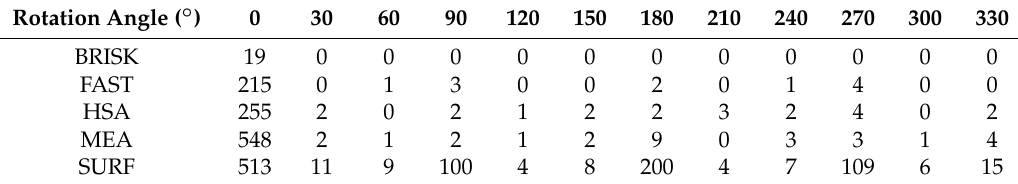
Table 3. The number of MIPs for the microscope rotation by a given angle (for the Figure 4 case). Rotation Angle ( ◦ )